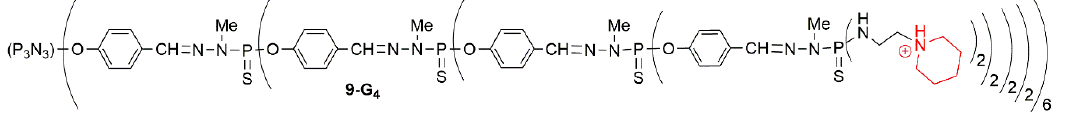
Figure 13. Generation 4 dendrimer used as a carrier of both 5-fluorouracil and a mixture of anti-cancer siRNAs.